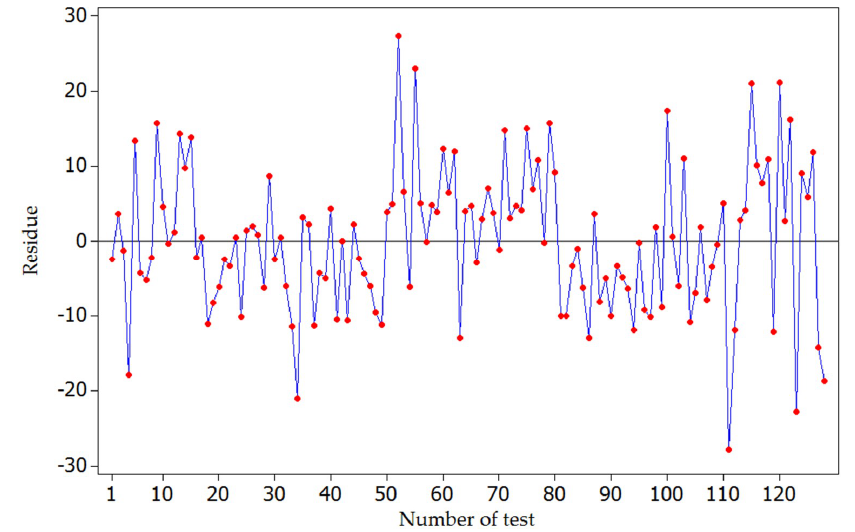
Figure 13. Residual vs size of selected standardized effects.